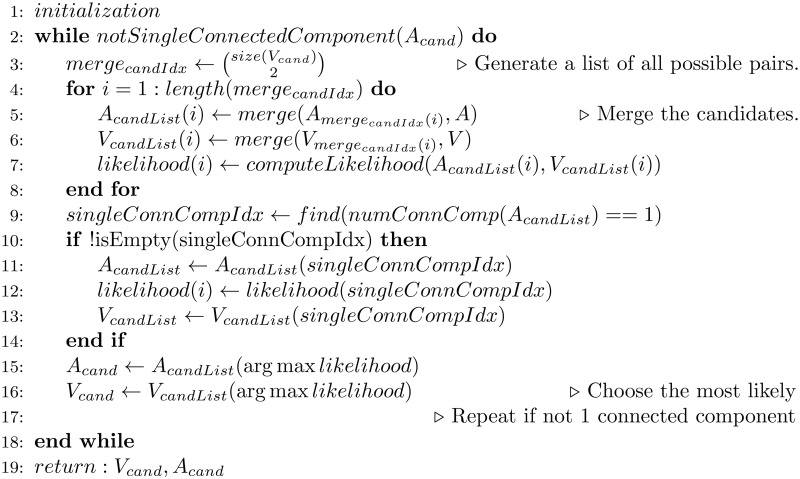
Pseudocode for merging protocol to select most likely from a set of candidate models provided none are simplicial complexes.